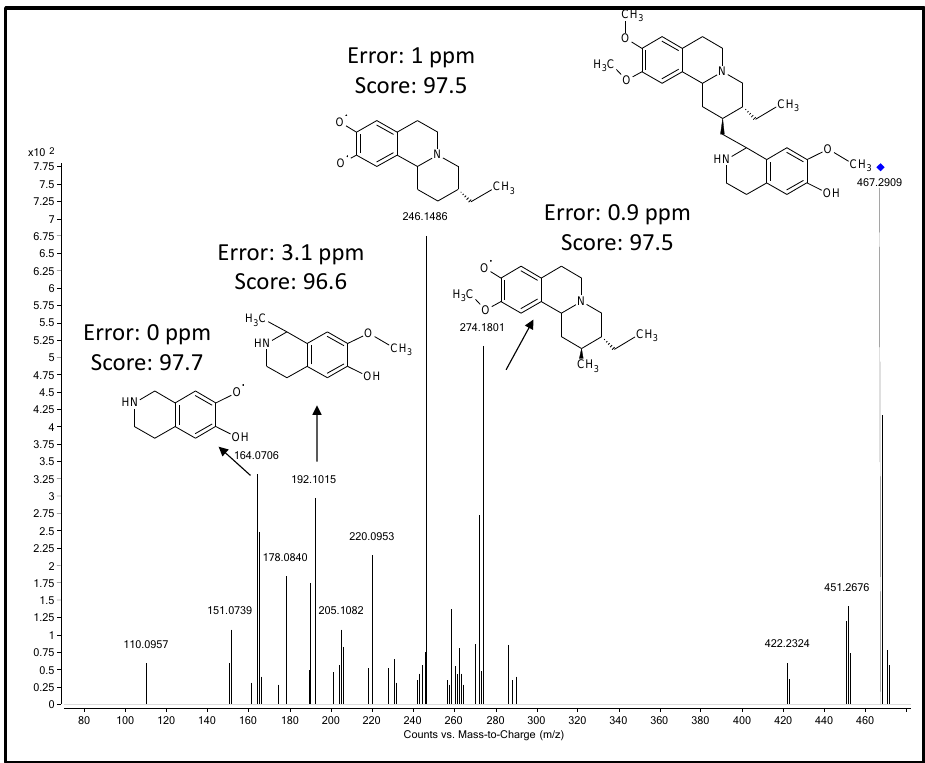
Figure 3. Results from Agilent MSC software tool for identifying the compounds that did not have a spectral match in the METLIN MSMS library.